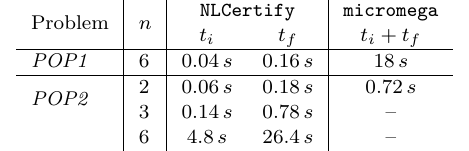
Table I. Comparing our formal POP checker with micromega , Problem